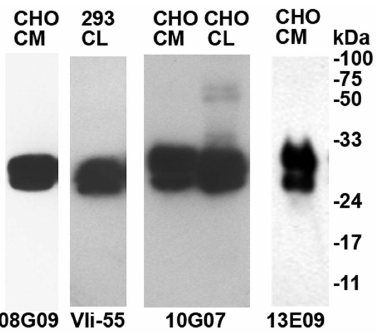
Figure 1. Characterization of anti-Cthrc1 monoclonal antibod- ies. HEK293T cells (293) and CHO-K1 cells (CHO) were transduced with human or rat Cthrc1 expressing adenovirus. Cell lysates (CL) or conditioned media (CM) were collected for immunoblot using four different antibodies as indicated. The double band recognized by all the antibodies represents Cthrc1 with partially cleaved signal peptide as determined by mass-spectrometry (data not shown). Mouse monoclo- nal antibody 08G09 reacts with rat and mouse Cthrc1 but not human, rabbit monoclonal Vli-55 is specific for the conserved C terminus present in all species, mouse monoclonal 10G07 detects only the N terminal epitope of human Cthrc1, mouse monoclonal antibody 13E09 detects an internal epitope present in mouse, rat and human